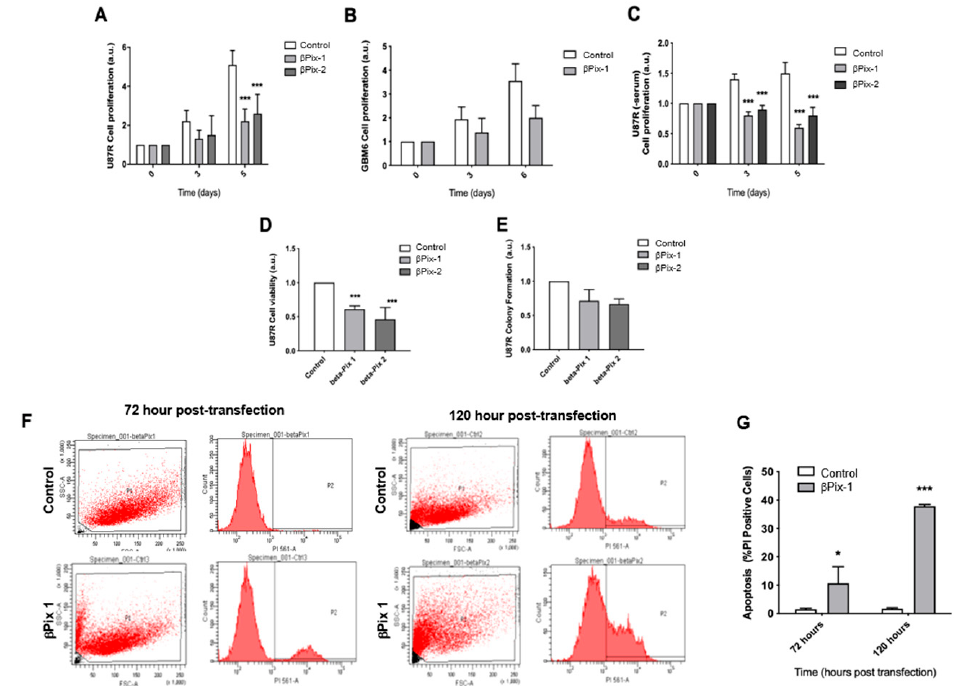
Figure 3. β Pix/COOL-1 depletion inhibits proliferation of U87R-GFP and GBM6 GBM cells. ( A , B ) The effect of β Pix/COOL-1 knockdown using two siRNA duplexes ( β Pix-1 and β Pix-2) on GBM cell proliferation using U87R-GFP and patient derived GBM6 cells ( C ) The effect of beta-Pix knockdown